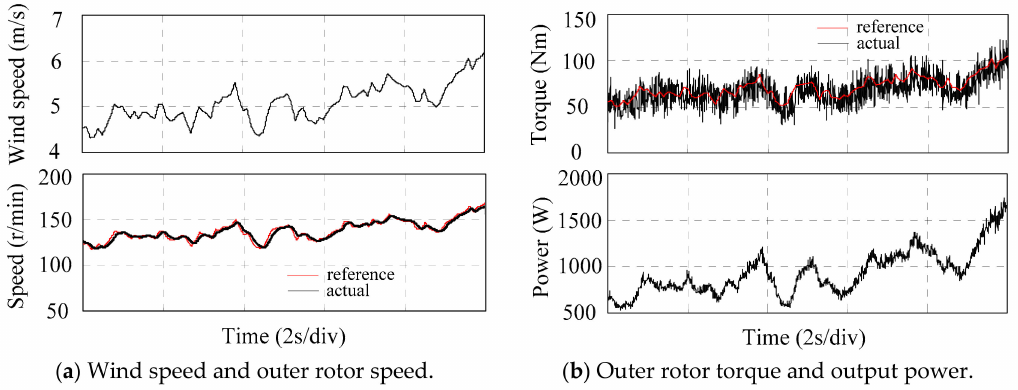
Figure 14. Experimental results of the MPPT control for the DPF-WECS.